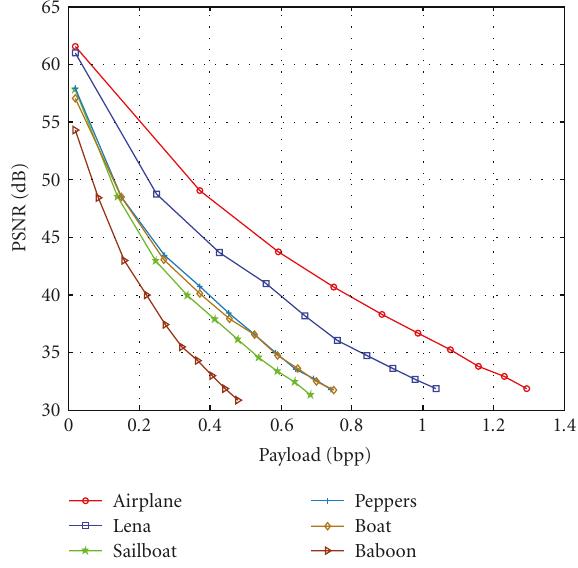
Figure 10: Comparison of payload versus PSNR for test images.